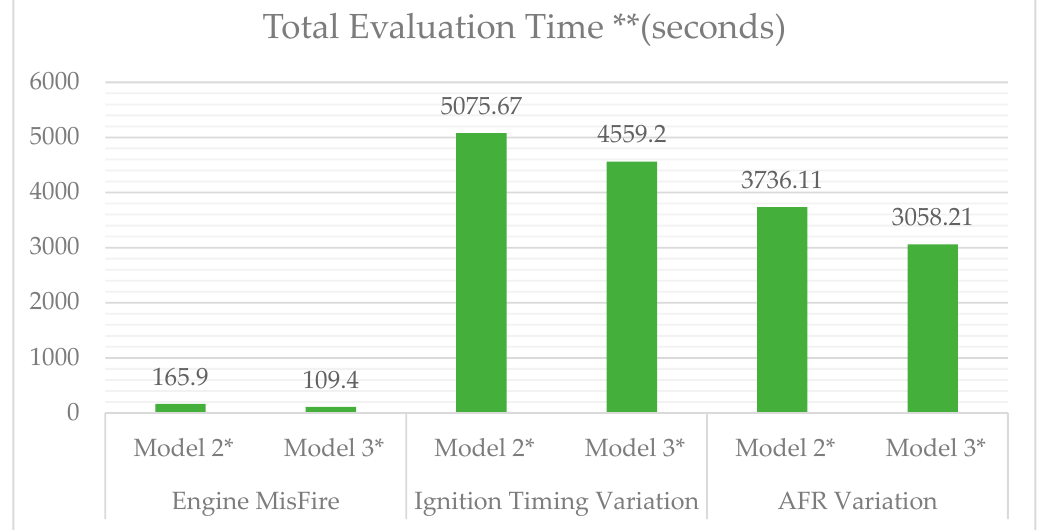
Figure 16. Evaluation time comparison for the models with three fault conditions. * Model 2, Bayesian optimization; * Model 3, PCA with Bayesian optimization. ** Computations were performed on a 2.7 GHz Intel dual Core i5 MacBook pro and programming was done in MATLAB R20.